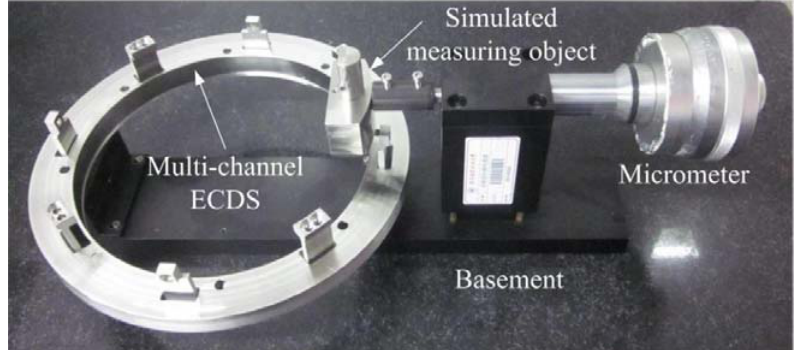
Figure 12. The calibration rig designed for the ECDS.